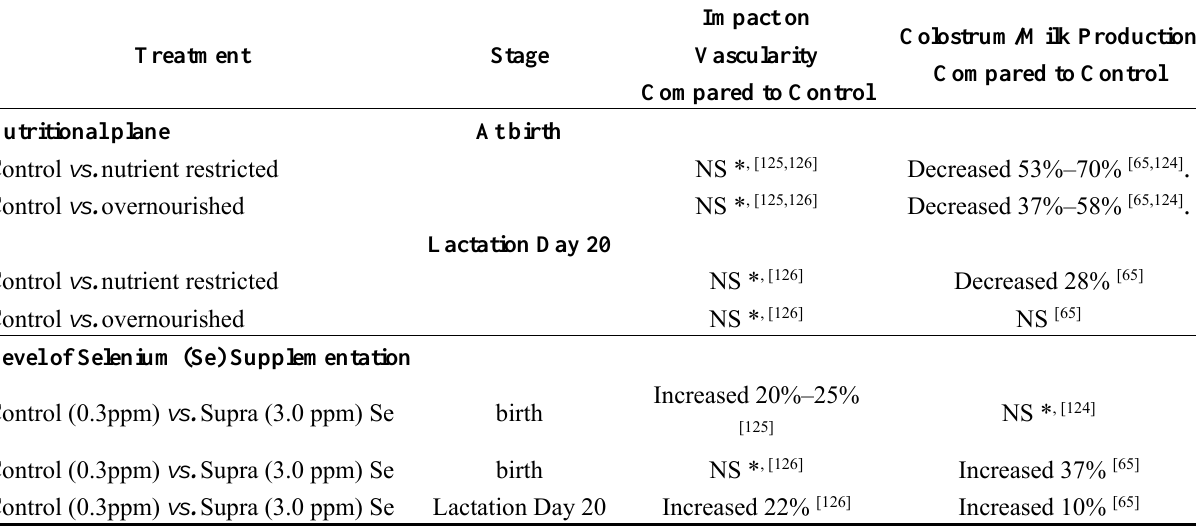
Table 6. Impacts of maternal diet during pregnancy on vascularity and production of the mammary gland in